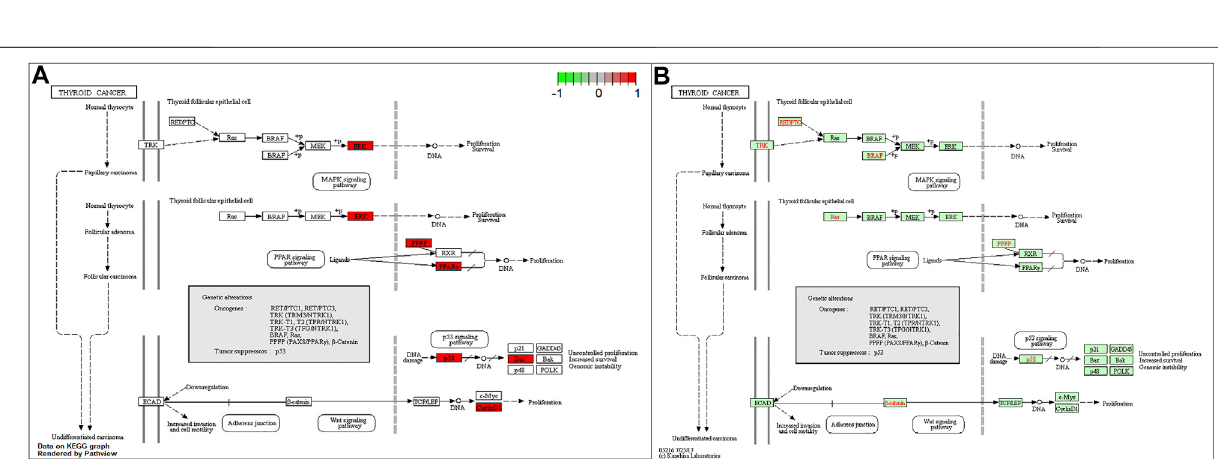
FIGURE 5 | GO and KEGG functional annotation pathway enrichments. The barplot (A, B) and the bubble (C, D) . The KEGG signaling pathways.